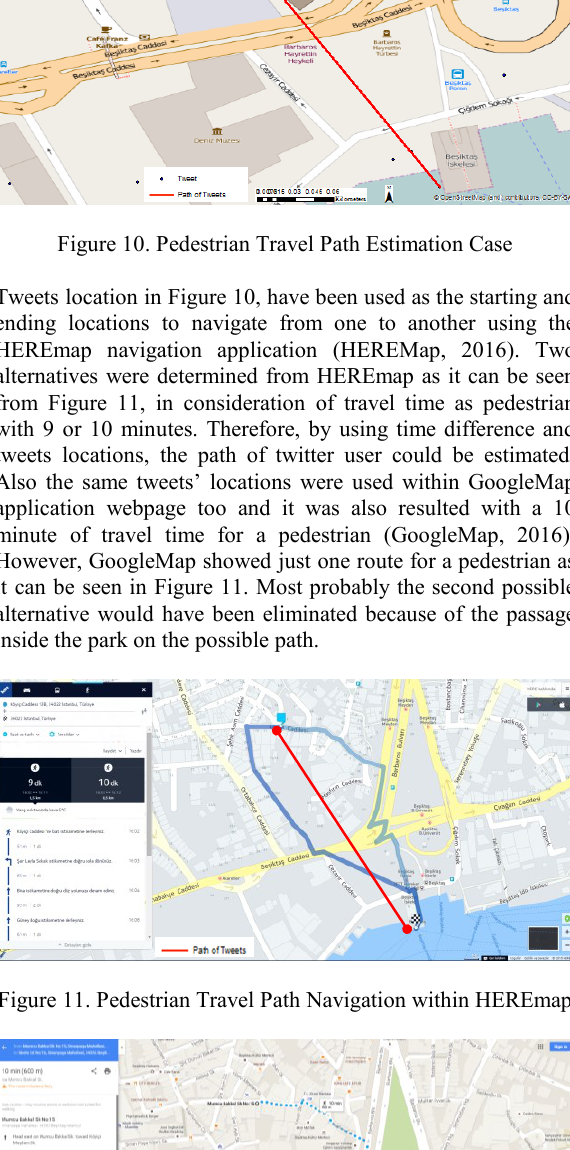
Figure 11. Pedestrian Travel Path Navigation within HEREmap